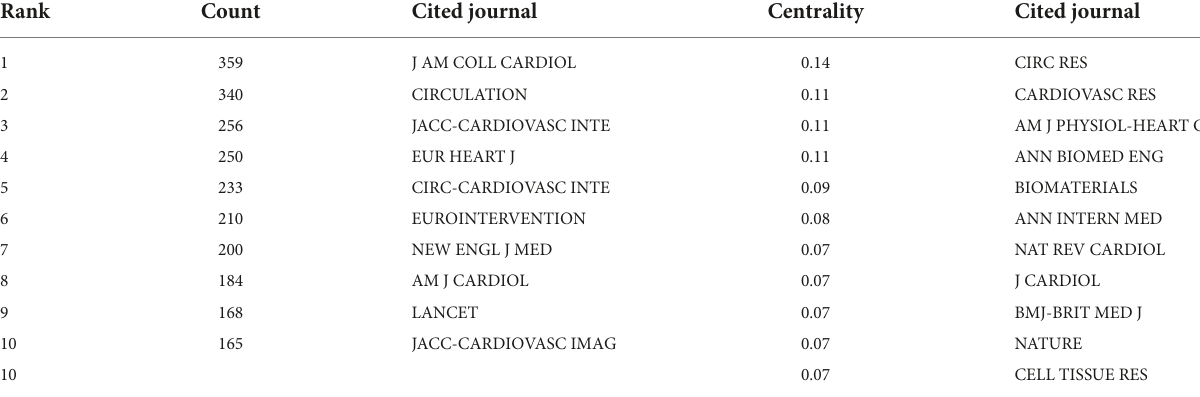
TABLE 7 The top 10 co-cited journal sorted by the number of